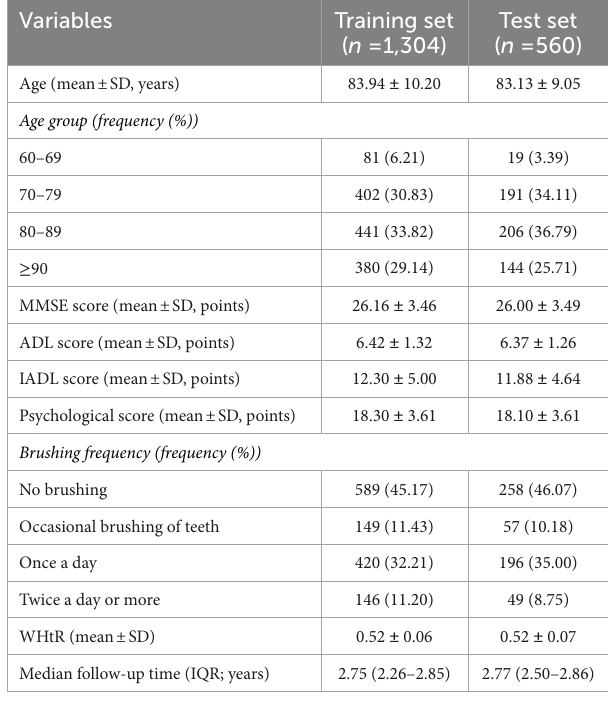
TABLE 2 Baseline characteristics of the participants in the training set and test set of the development cohort.